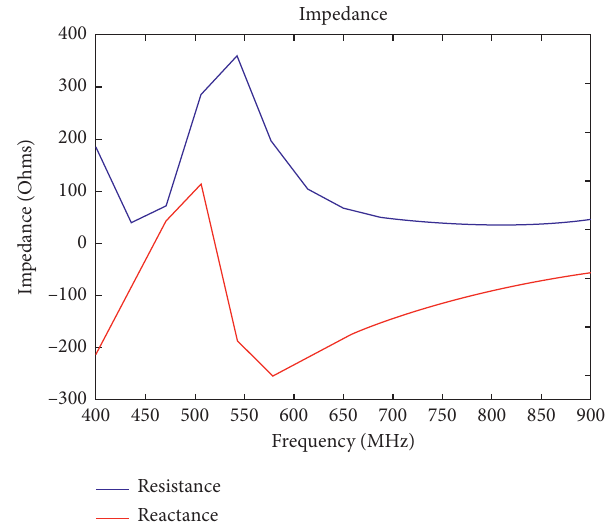
Figure 17: Two-iteration fractal Koch antenna impedance along the bandwidth.